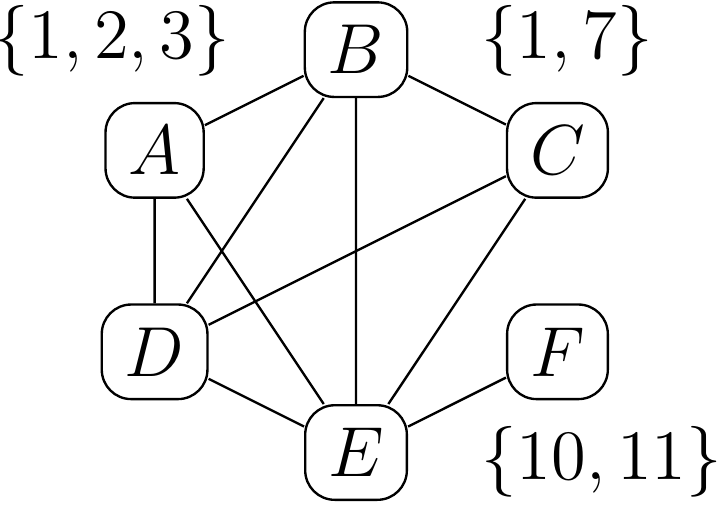
Figure 2. The atom graph of G . (the edge labels that are equal to 1 are